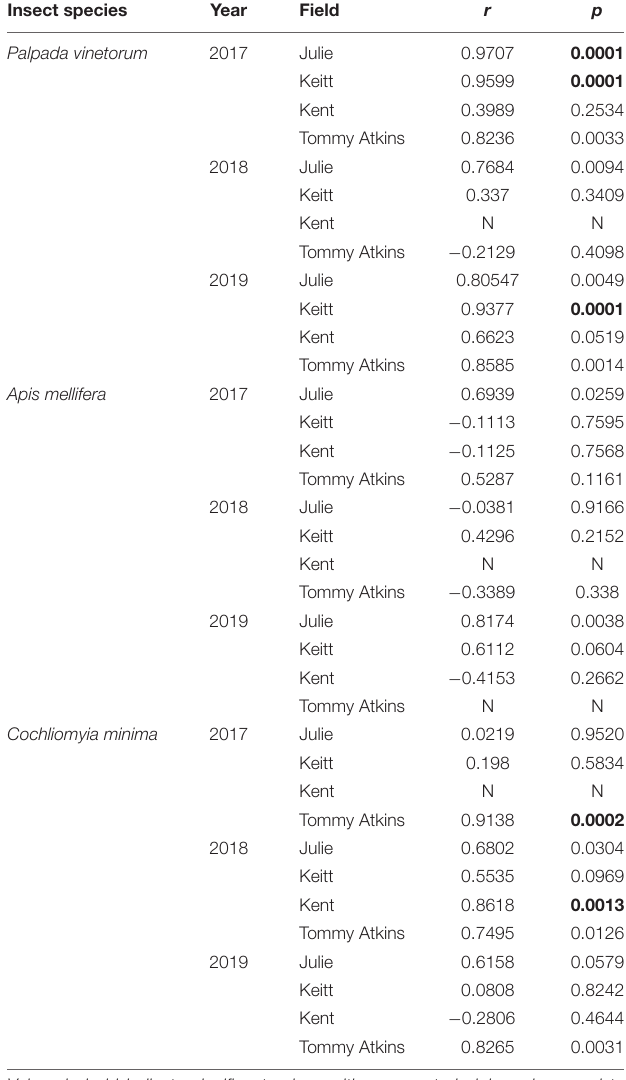
TABLE 5 | Pearson correlation coefficients for the number of fruits per tree and the abundance of dominant insect species per year per field. Insect